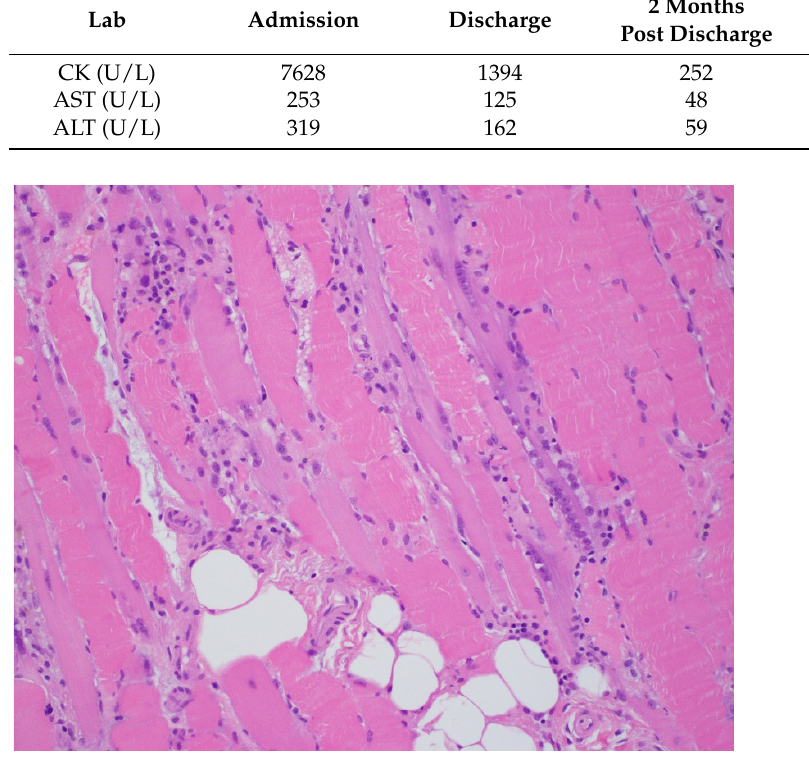
Figure 1. Hematoxylin and eosin stain: segmental necrosis and inflammatory infiltrate without vessel wall destruction.